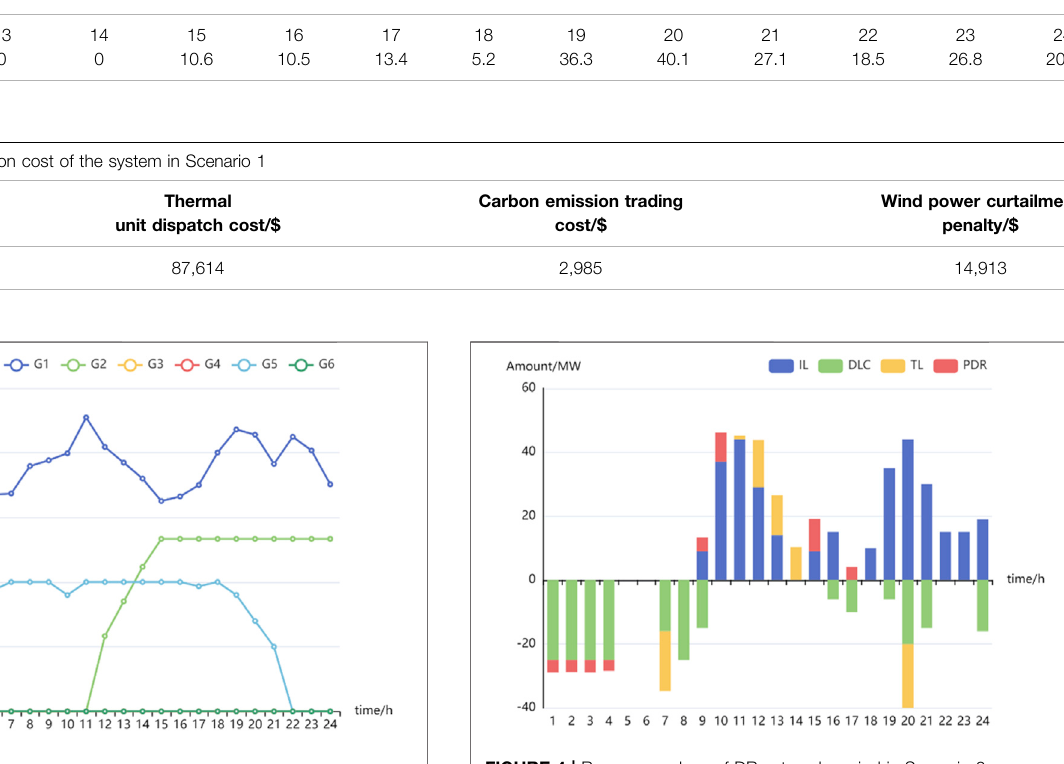
FIGURE 3 | Outputs of thermal units at each period in Scenario 2 FIGURE 4 | Response values of DRs at each period in Scenario